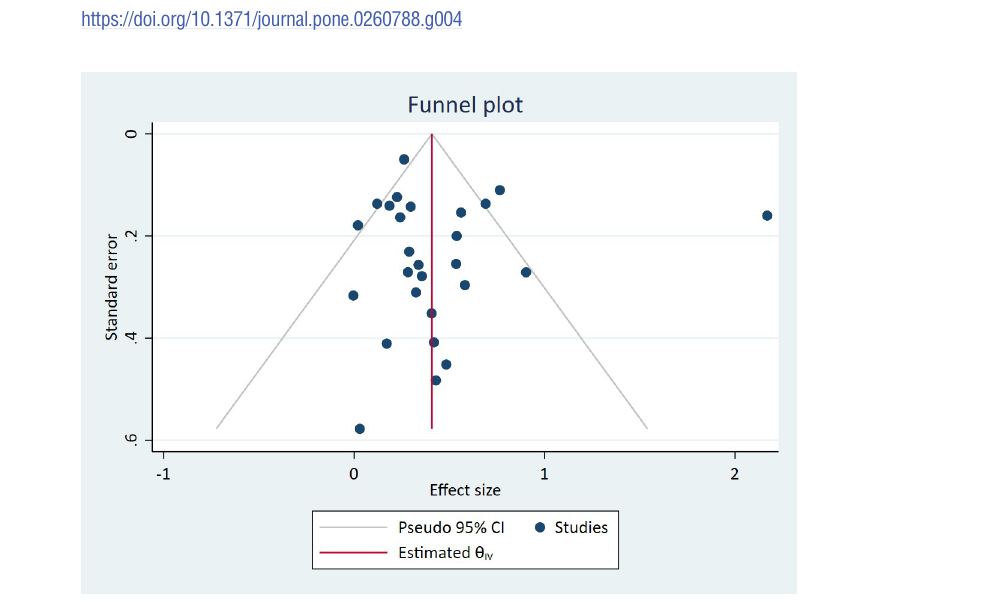
Fig 4. Meta-analysis of the association between socioeconomic position and complex working memory (sorted by effect size). Note: A double asterisk �� indicates a cohort or longitudinal study. Effect sizes to the right of the 0 line favour the higher socioeconomic positioned groups.